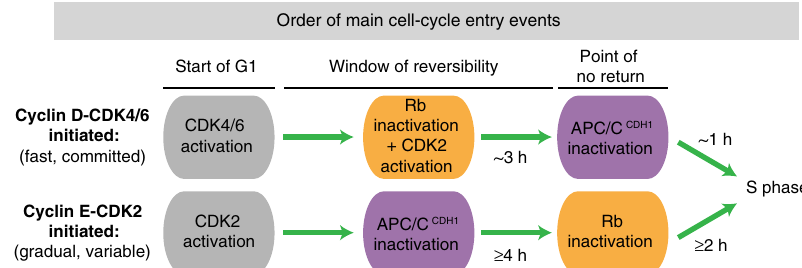
Fig. 7 Working model. Distinct regulatory programs in cells entering the cell cycle with and without CDK4/6